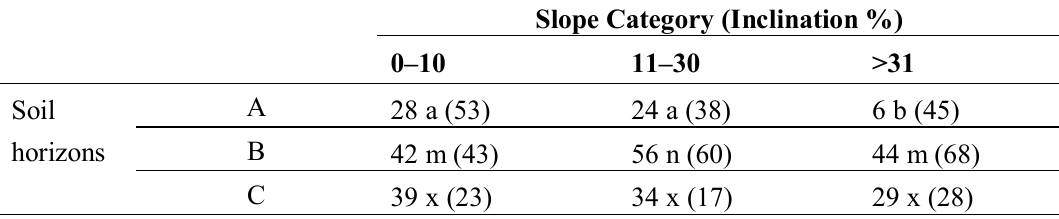
Table 1. Soil horizons and horizon thickness (cm) of 21 soil profiles representing three slope